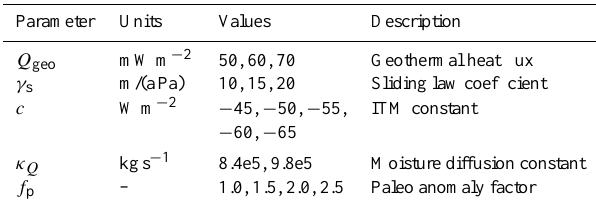
Table 1. All parameter values used to generate the ensemble of model